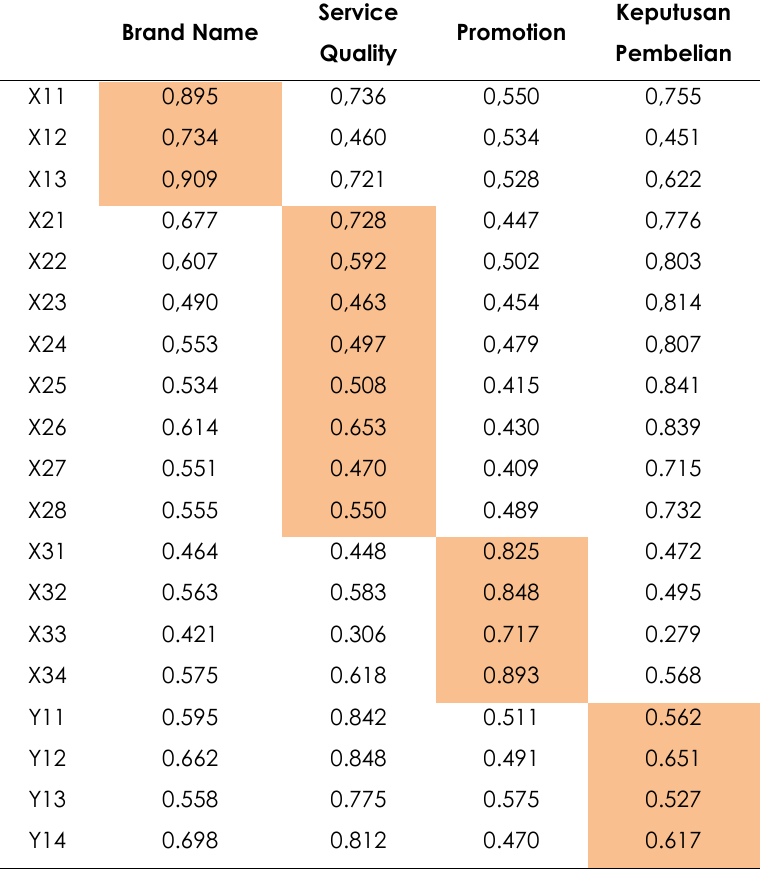
Tabel 7. Cross Loading